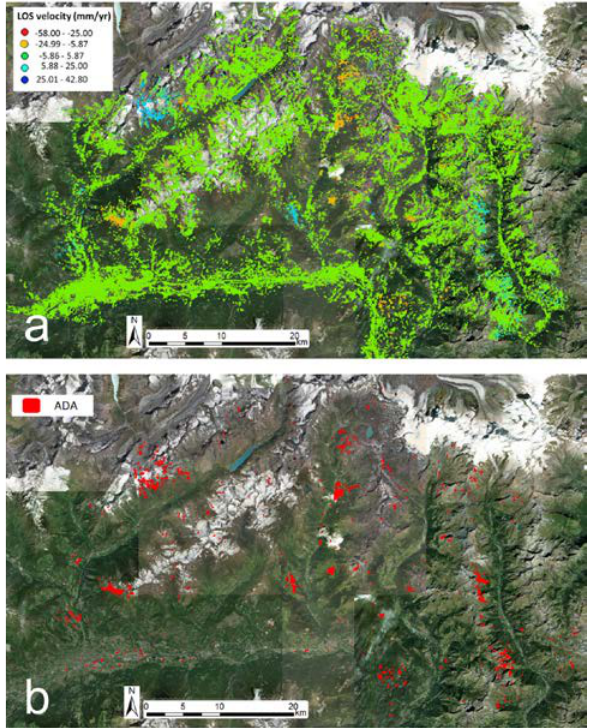
Figure 7: Example of ADA distribution in the Valle d’Aosta test site. (A) Line of Sight velocity (mm/year); (B) ADA map